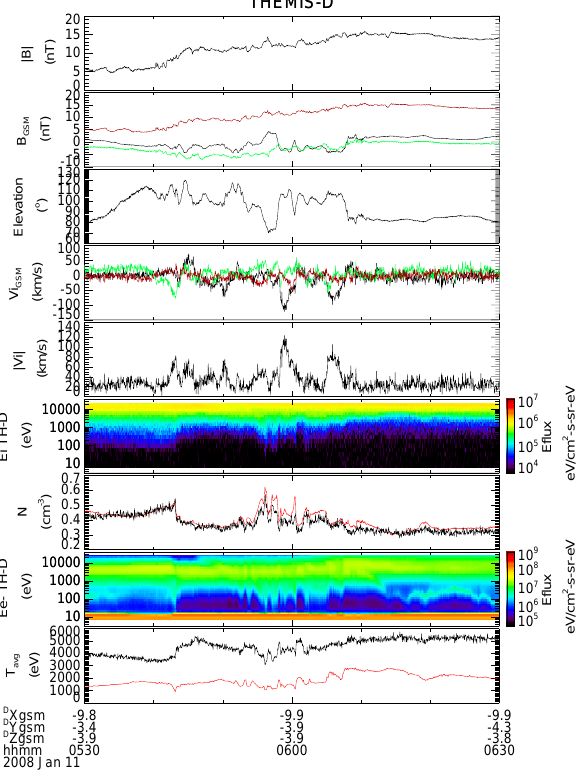
Fig. 6. Themis D observations in the same format and for the same time period as Fig. 2, except that the Rankin Inlet magnetometer data is not